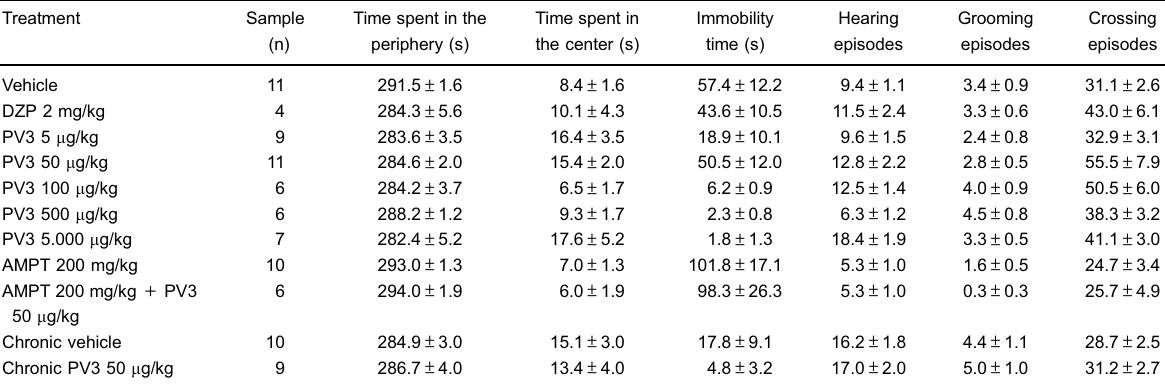
Table 3. Summary of parameters analyzed in the open fi eld experiments.